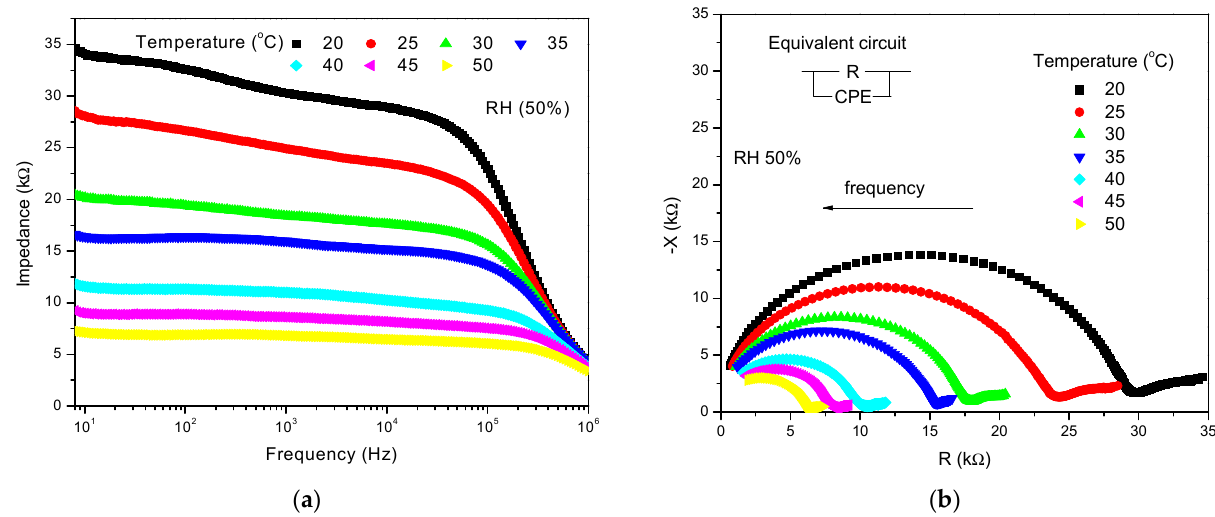
Figure 8. Impedance dependence on frequency at RH 50% ( a ) and complex impedance ( b ) measured in the temperature range of 20–50 °C; inset in ( b ) shows the applied equivalent circuit.